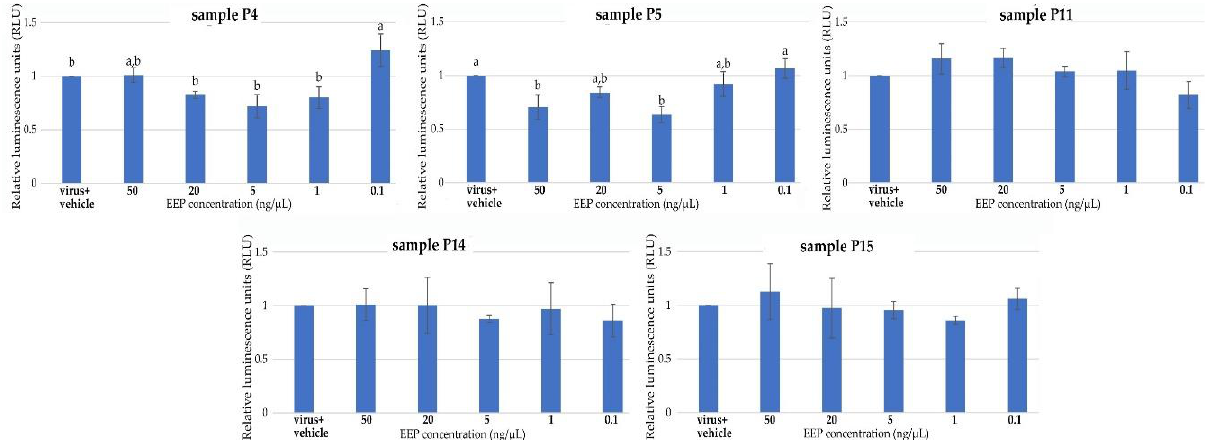
Figure 5. The effect of selected propolis extracts (samples P4, P5, P11, P15, and P15) on HPV16 (PsVs) infection. The data are expressed as the mean viability from three independent experiments in each case. (Values denoted with identical letters do not differ significantly; values without letters in graphs were statistically insignificant).